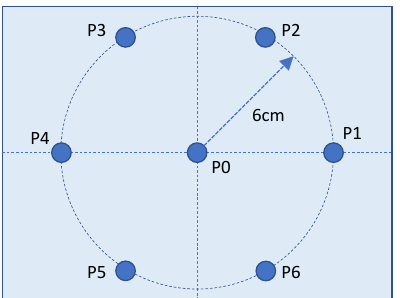
Figure 7. Antenna positions on the measurement